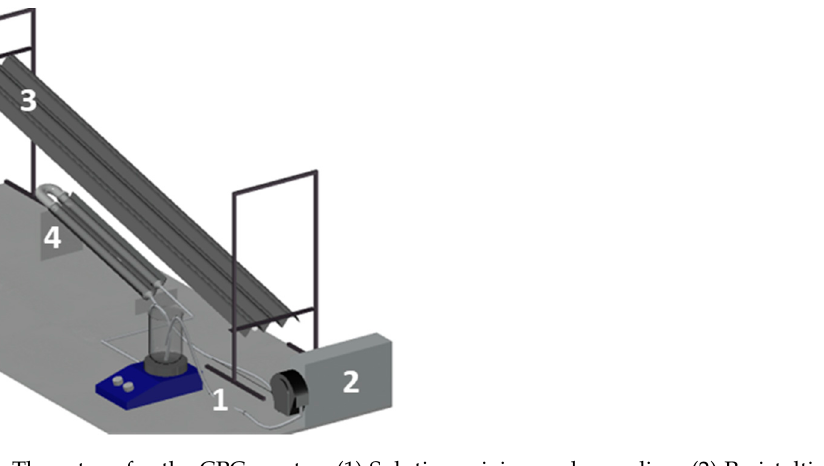
Figure 8. The set up for the CPC reactor. (1) Solution mixing and sampling; (2) Peristaltic pump; (3) Irradiation source; (4) CPC reactor.